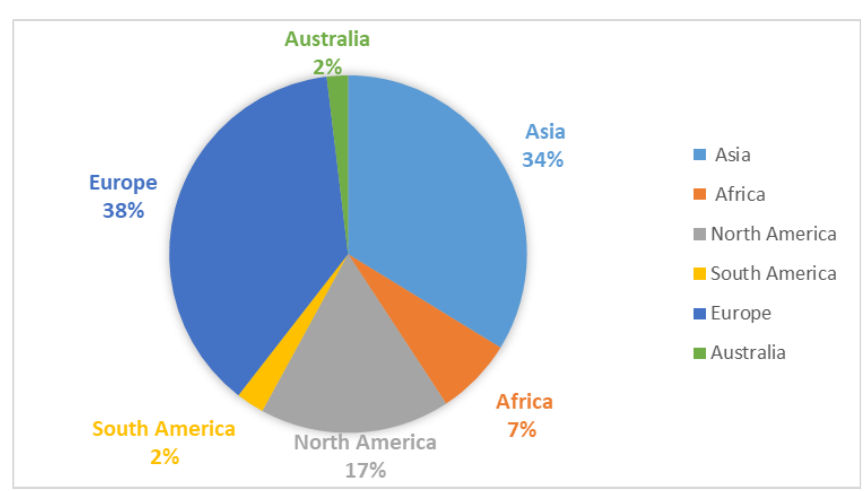
Figure 6 . Published papers by continent . Figure 6. Published papers by